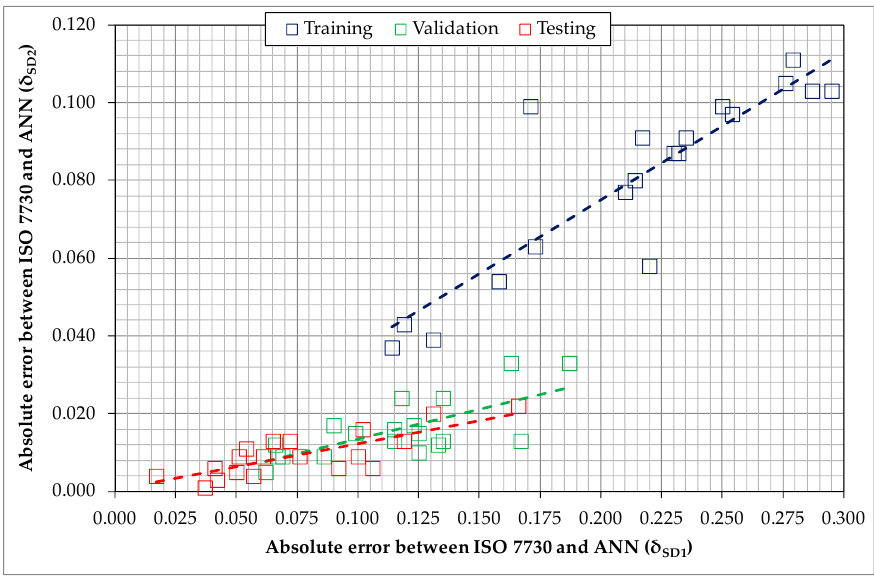
Figure 6. Absolute error returned by ANN in each development process considering all the sample of data ( δ SD1 ) and the ones fall in [21–28 °C] and [30–75%] ranges of temperature and relative humidity ( δ SD2 ).